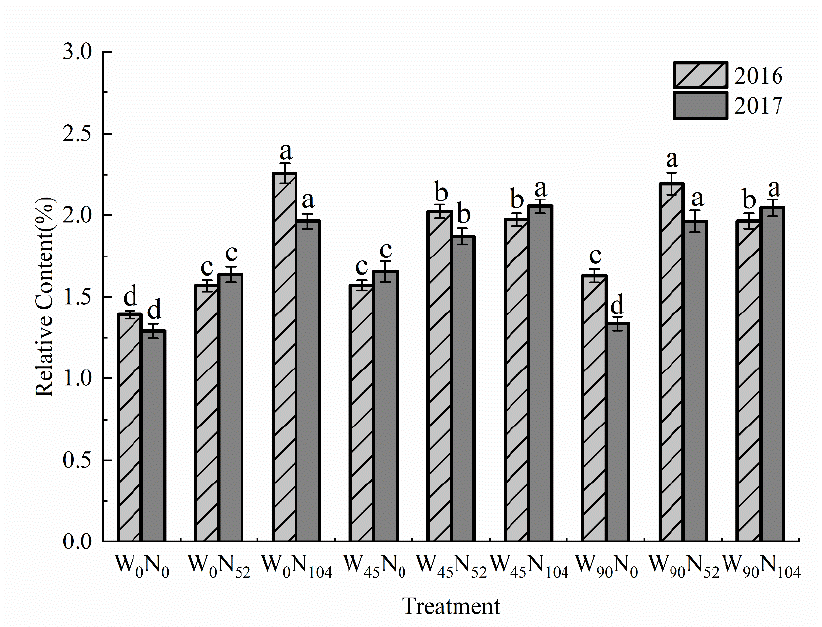
Figure 5. Effects of irrigation, nitrogen, and the interaction between the two on aspartic acid content of sunflower seed kernels (mean ± SD; different lowercase letters indicate that there are significant differences in nine treatments at the 5% level in 2016 and 2017, respectively).